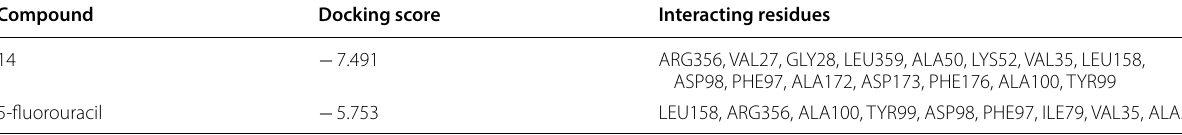
Table 4 Docking score and binding energy of compound 14 with standard drug